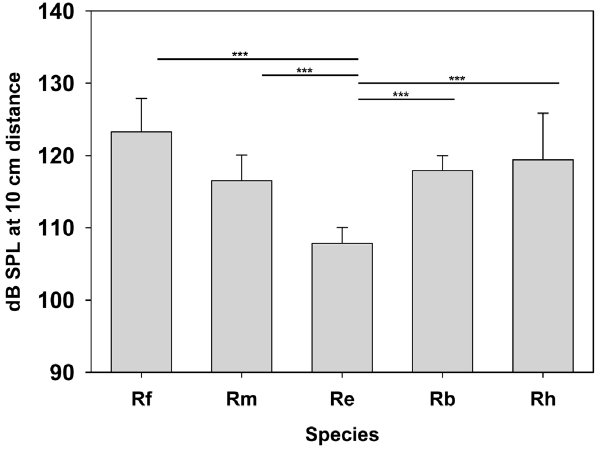
Figure 2. Interspecific call intensity relations. Maximum call intensities (in dB SPL; calculated for 10cm distance to the bats’ nose) for R. ferrumequinum (Rf, N=12), R. blasii (Rb, N=6), R. mehelyi (Rm, N=11), R. euryale (Re, N=12) and R. hipposideros (Rh, N=10). Lines and asterisks indicate the significant outcomes from all possible post-hoc pair wise comparisons (t-tests, p-values Bonferroni corrected, *** , 0.0001).